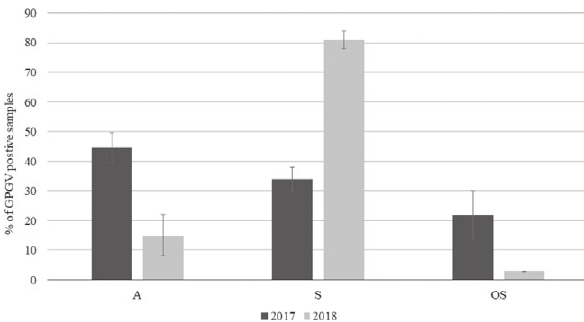
Figure 2. Mean proportions (%) of GPGV infected plants in 2017 and 2018 in different symptom classes of asymptomatic (A), symp- tomatic for GLMD (S) or with symptoms of other virus diseases (OS). Percentages were calculated for total numbers of positive samples in the two years of